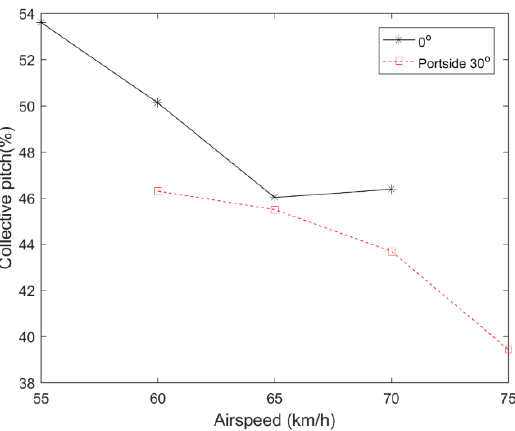
Figure 20. Collective pitch under 0° and portside 30° WOD conditions.